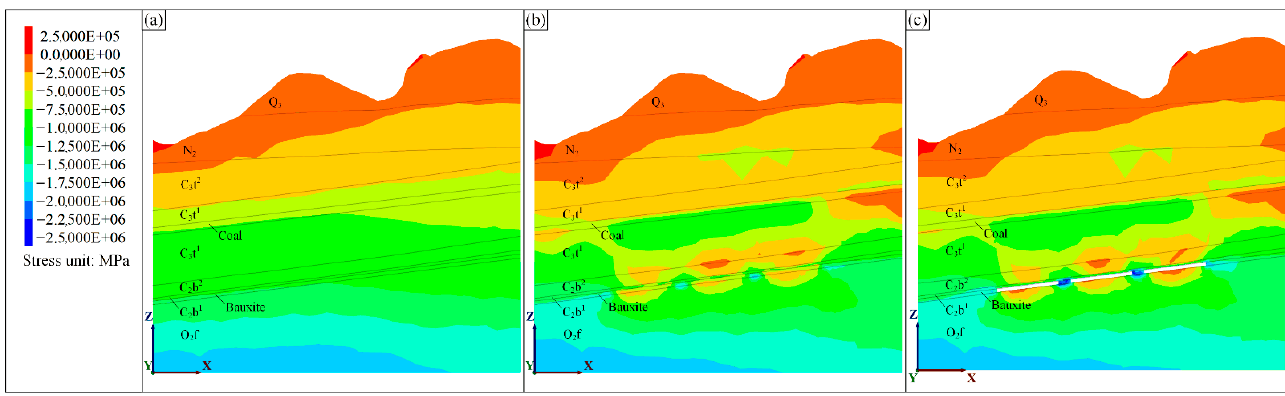
Figure 6. Distribution of maximum principal stress: ( a ) non-mining condition; ( b ) normal backfilling condition; ( c ) non- backfilling condition.